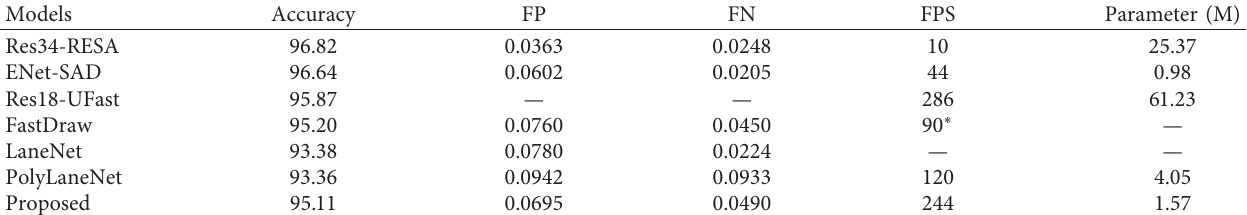
Table 2: Comparison with state-of-the-art methods on TuSimple dataset. Use PyTorch to test FPS and parameter at 3 ∗ 360 ∗ 640 resolution on NVIDIA RTX 2070s. Data with “ ∗ ” mark is obtained from the original text.